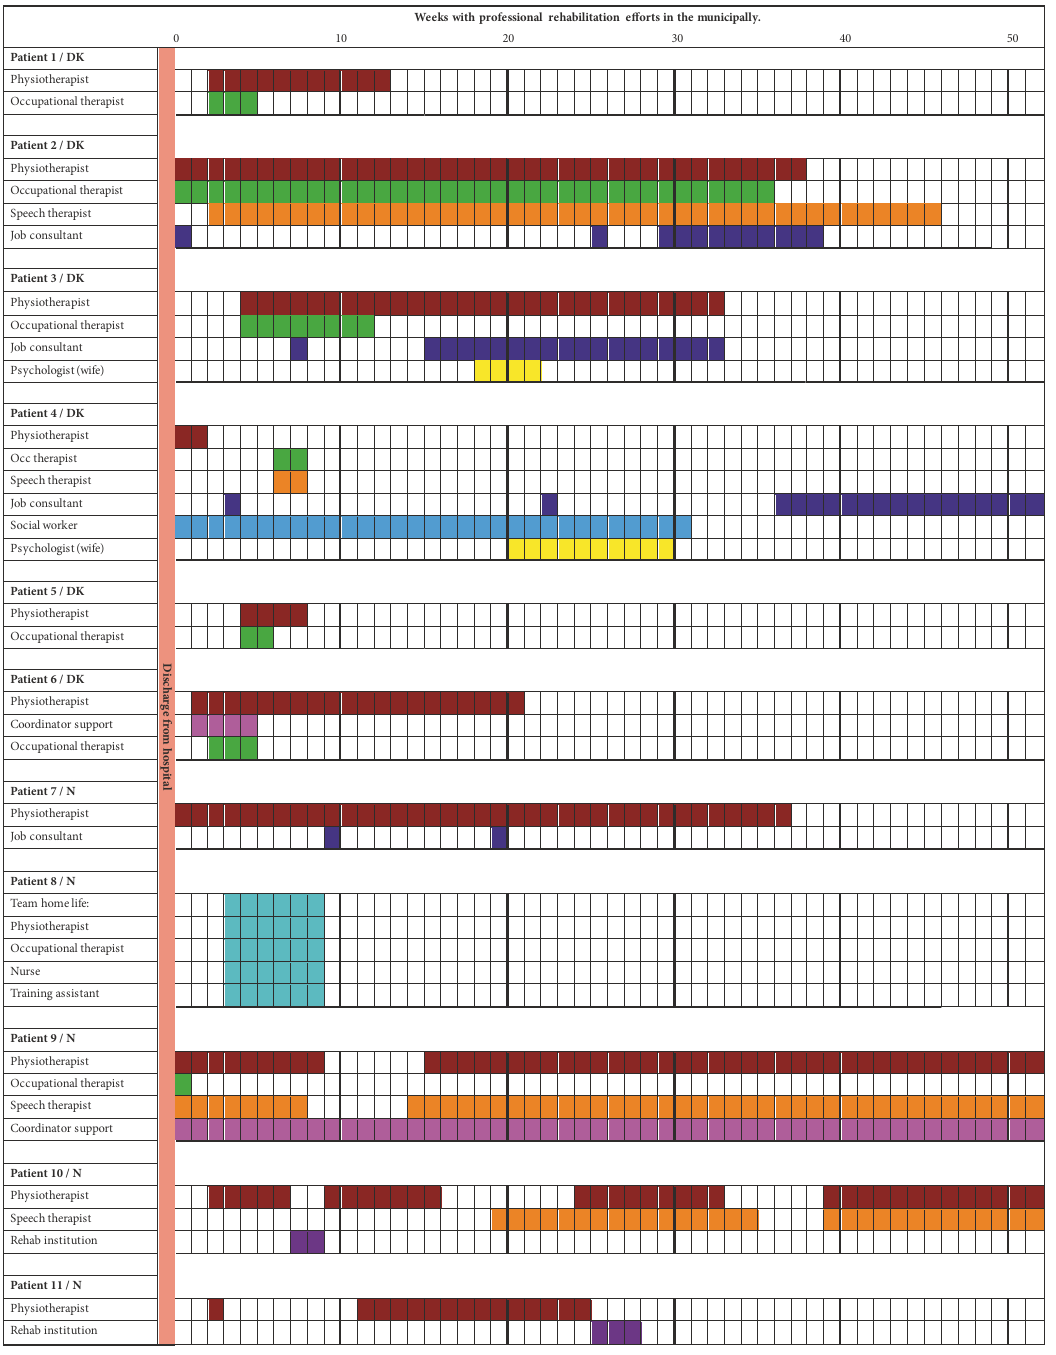
Figure 1: Duration of different professional rehabilitation